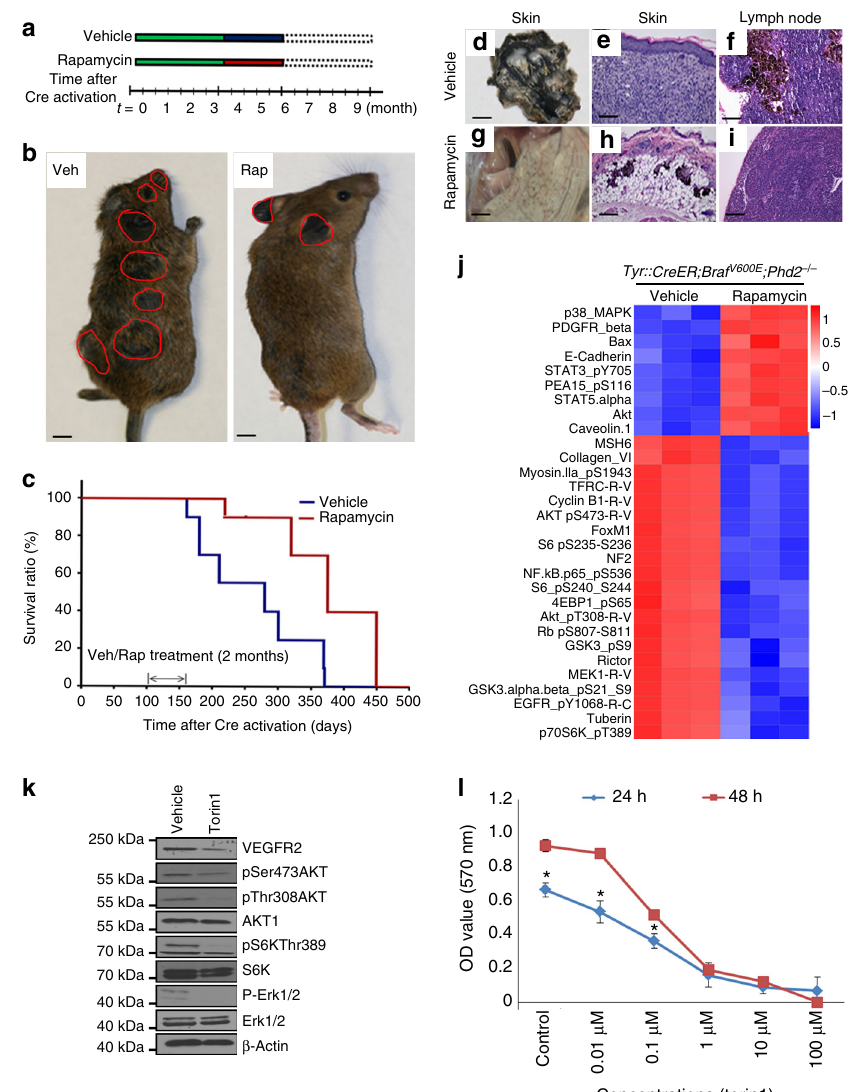
Fig. 7 Inhibition of mTOR pathway suppresses the growth of melanoma in vivo. a Scheme of rapamycin treatment. b Representative images of Tyr::CreER ; BRaf V600E ; Phd2 − / − mouse treated with the vehicle control (left panel) or rapamycin (right panel). Rapamycin treatment lasted for 8 weeks. Tumor masses are highlighted by red circles. c Kaplan – Meier survival curves of mice treated with vehicle control ( n = 10) or rapamycin ( n = 10) and p < 0.05. d – i Representative images of skin and lymph nodes in mice treated with the vehicle control or rapamycin. After killing the mice, underside of skin was exposed and photographed ( d , g ). The entire dermis was occupied by tumor cells ( e ) and lymph node was positive for melanoma in the vehicle-treated mice ( f ). On the contrary, there were signi fi cantly fewer tumor cells in the dermis ( h ) with negative lymph node ( i ) in the rapamycin-treated mice. j Inhibition of the Akt – mTOR pathway resulted in tumor growth suppression. Tumor tissues with or without rapamycin treatment were processed and analyzed using RPPA assays. Proteins with most signi fi cant changes were used to generate the heatmap. Notably, phospho-Rb S807/811 , phospho-AKT S473 , Cyclin B1, TFRC, phospho-S6 S235/236 , phospho-EGFR Y1068 , MEK1 and phospho-AKT T308 proteins were signi fi cantly reduced in mice treated with rapamycin. k Torin1 inhibits Akt – mTOR pathway. BRaf V600E ; Phd2 − / − melanoma cells were treated with torin1 for 48 h. Western blot analysis was performed. Results are representative of three independent experiments. l Torin1 inhibits BRaf V600E ; Phd2 − / − melanoma cell growth. The melanoma cells were treated with different concentrations of torin1 (Control, 0.01, 0.1, 1, 10 and 100 μ M) and different lengths of time (24 or 48 h). Results are summary of three independent experiments. Bars in b indicate 6 mm. Bars in d , g indicate 3 mm. Bars in e , f , h , i indicate 100 µ m. * p < 0.05 compared to control ( t -test); error bars indicate